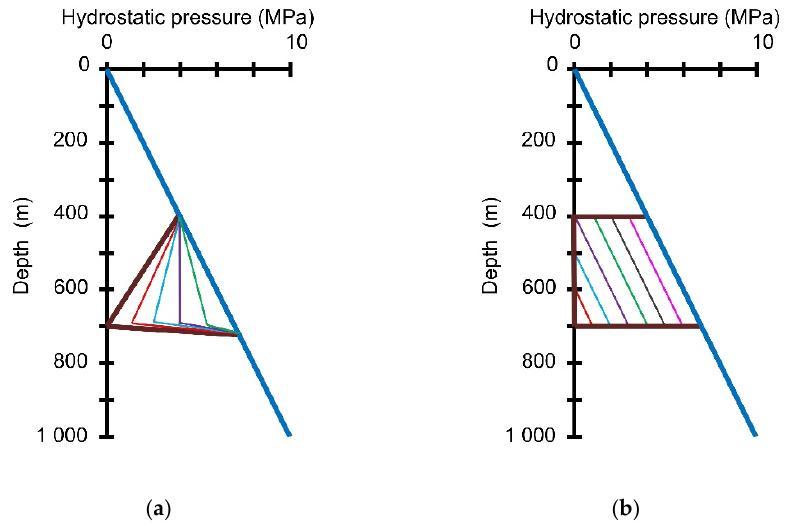
Figure 3. Variation of the water pressure as a function of depth for the situation that along this line the top longwall panel is situated at a depth of 400 m and the bottom panel at a depth of 700 m: ( a ) based on the approach in [17]; ( b ) adapted from the conditions presented in